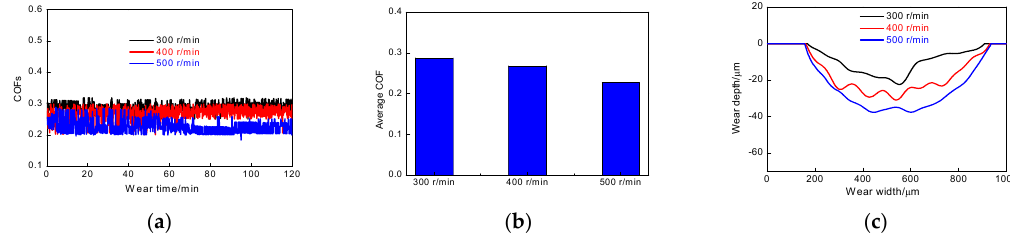
Figure 5. COFs vs. wear time and wear profiles of cold sprayed Al coatings after LR at different wear speeds. ( a ) COFs vs. wear time; ( b ) Average COFs; ( c ) Wear profiles.